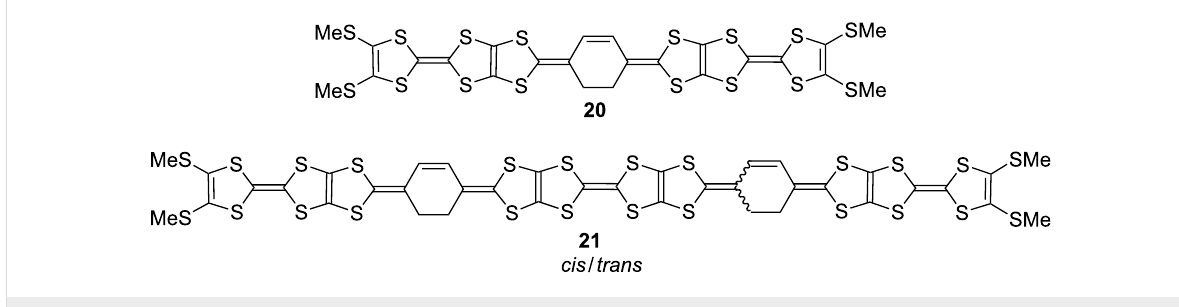
Figure 9: Molecular structures of 20 and 21